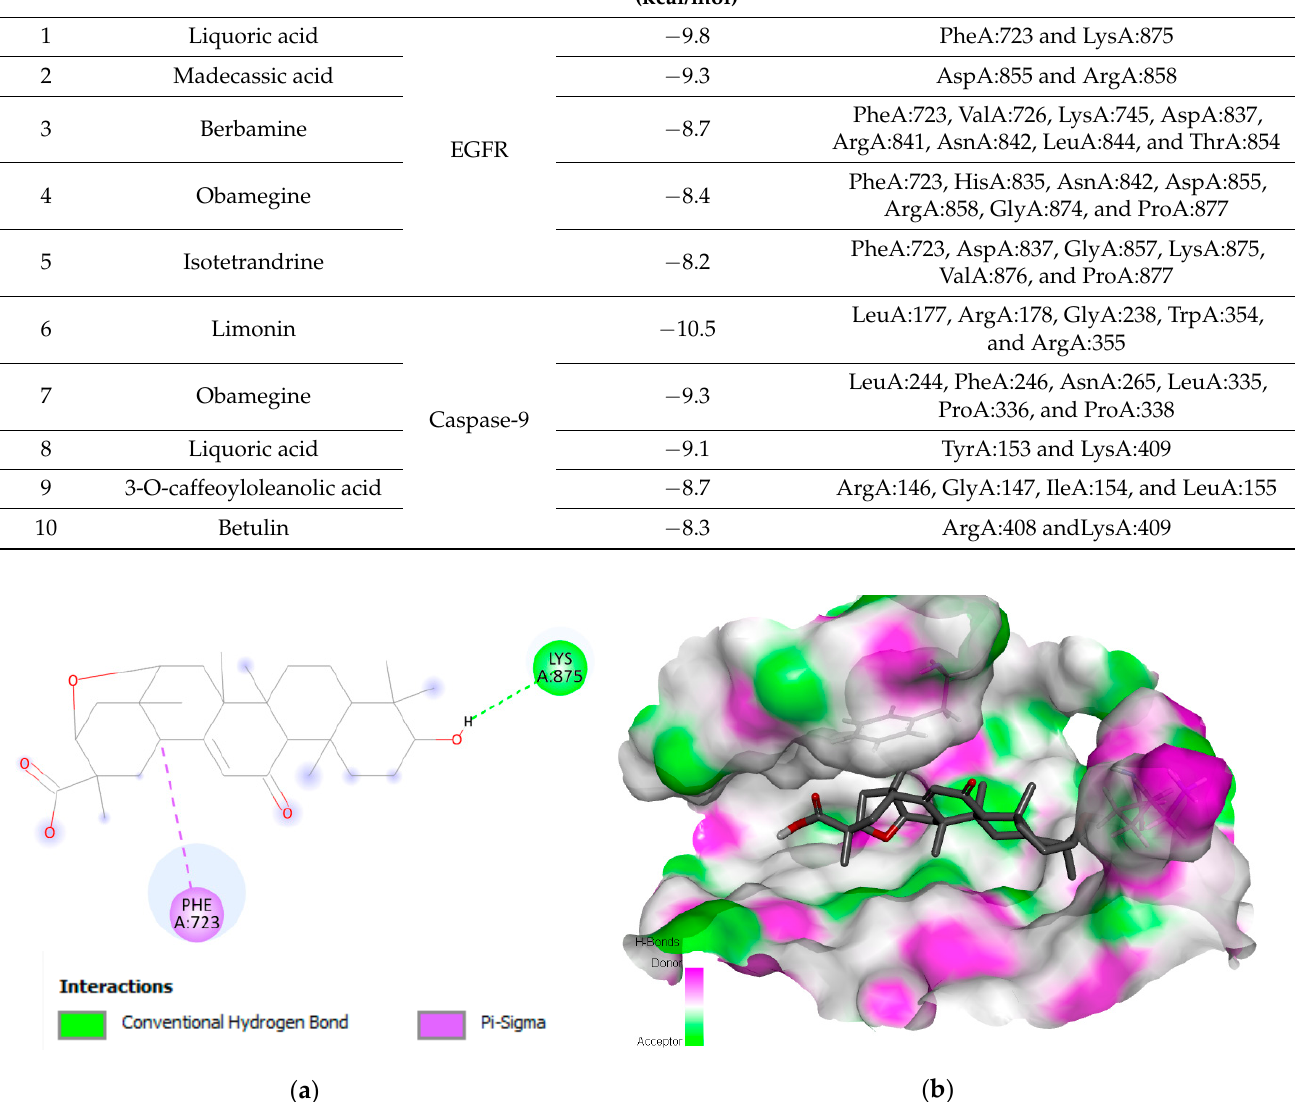
Figure 1. Interaction ( a ) and binding pattern ( b ) of liquoric acid with EGFR as a receptor. Similarly, the second best phytochemical madecassic acid (S-score of − 9.3 kcal/mol) revealed interactions with AspA:855 and ArgA:858 amino acids at the binding site of EGFR (Figure 2). Other phytochemicals such as berbamine, obamegine, and isotetrandrine also interacted with PheA:723 as a common interacting residue of the binding pocket of the EGFR protein. The amino acids AspA:837, AsnA:842, AspA:855, ArgA:858, and ProA:877 were found to be common in different complexes (Figures S1–S3). For the caspase-9 target protein, the best phytochemical limonin with a binding affinity of − 10.5 kcal/mol interacted with LeuA:177, ArgA:178, GlyA:238, TrpA:354, and ArgA:355 amino acids of the active pocket (Figure 3). Two conventional H-bonds (i.e., GlyA:238 and ArgA:355) were observed in this complex. Similarly, the